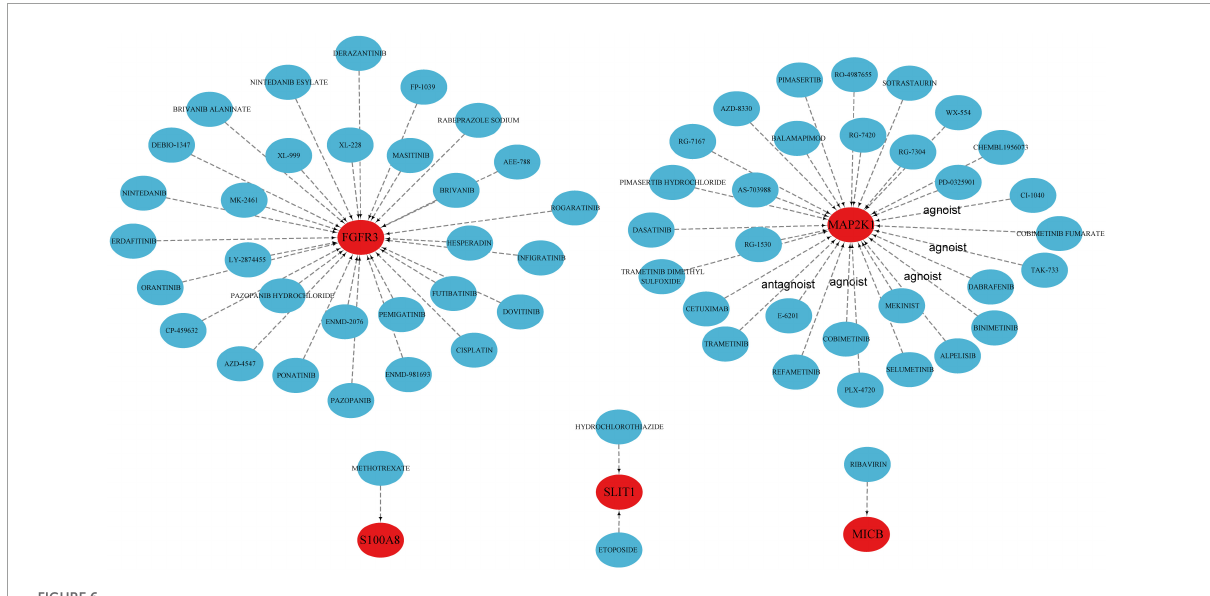
FIGURE6 Prediction of marker gene-targeted